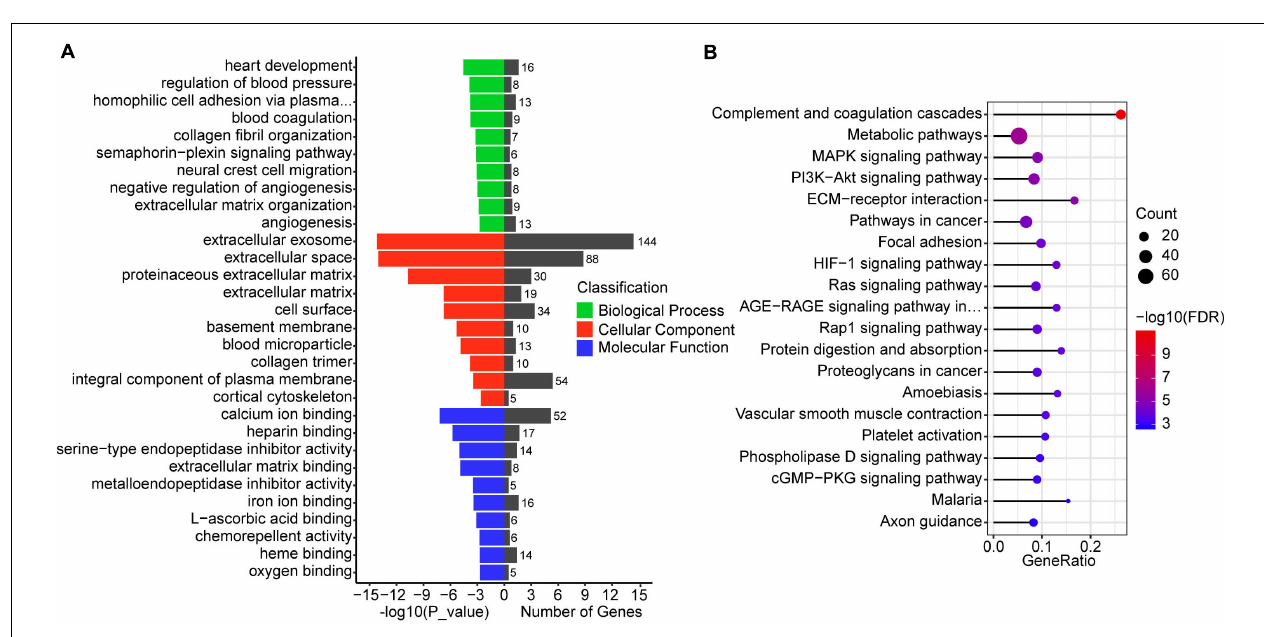
FIGURE 3 | Validation of DEGs by qRT-PCR. Expression patterns of eight DEGs on days 9, 12, and 15 of pregnancy were determined by qRT-PCR and compared with profiles obtained by RNA-seq. White bars indicate RNA-seq expression level; black indicate q-PCR expression level. The correlation coefficient r represents a correlation between q-PCR and RNA-seq-based gene expression. Detailed results are shown in Supplementary Table 4 . RBP4: retinol binding protein 4; VIM: vimentin; PSAP: prosaposin; PLPP1: phospholipid phosphatase 1; IL1B2: interleukin 1, beta 2; IFNG: interferon gamma; SFN: stratifin; and CA2: carbonic anhydrase 2.